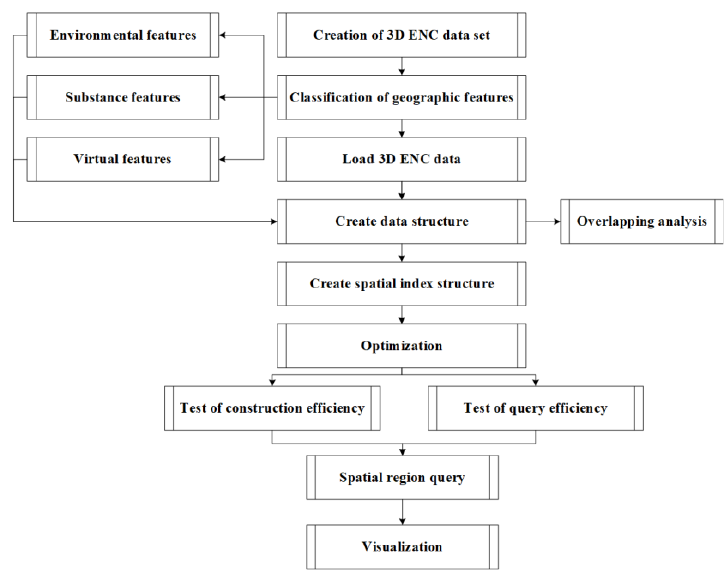
Figure 2. Organizational structure of this article.